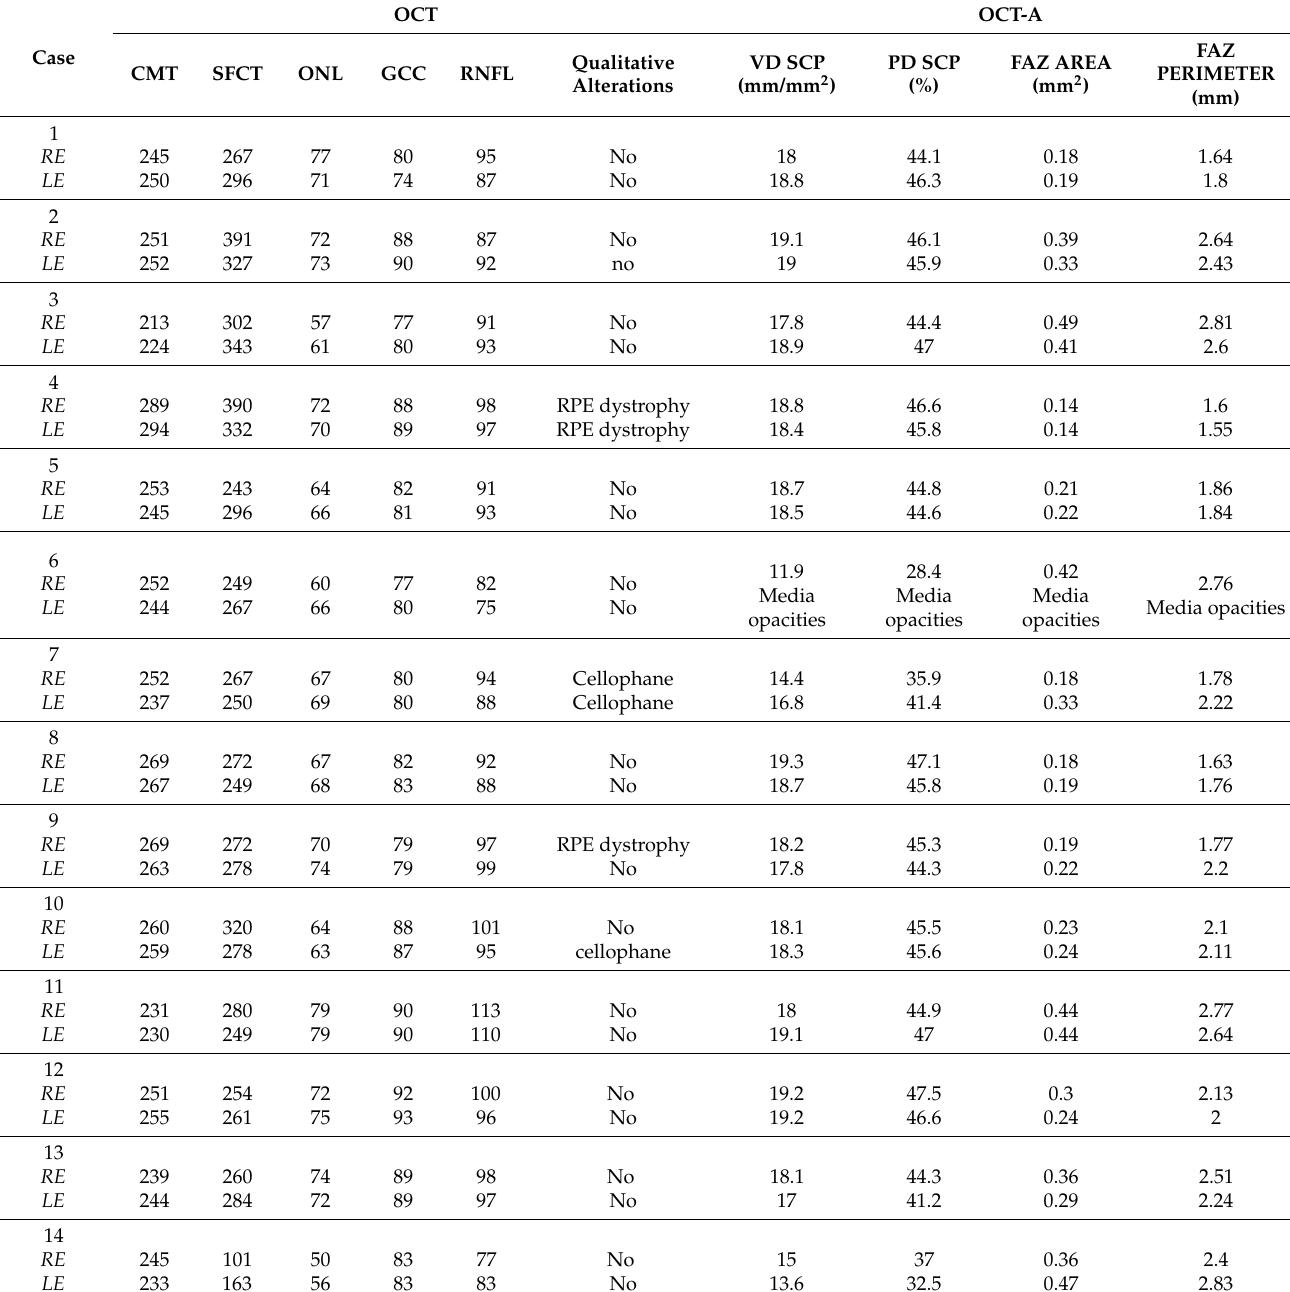
Table 3. OCT and OCT-A